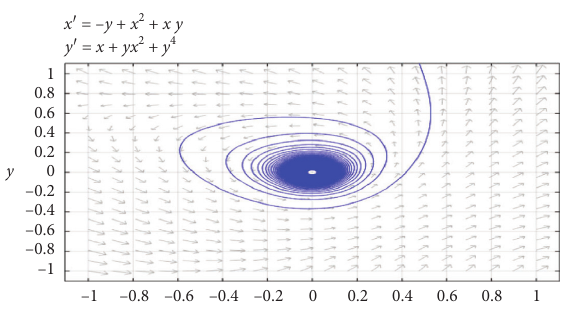
Figure 3: Existence of limit cycle for system (6), when k � 1, l � 1, m � 1, n � 1.